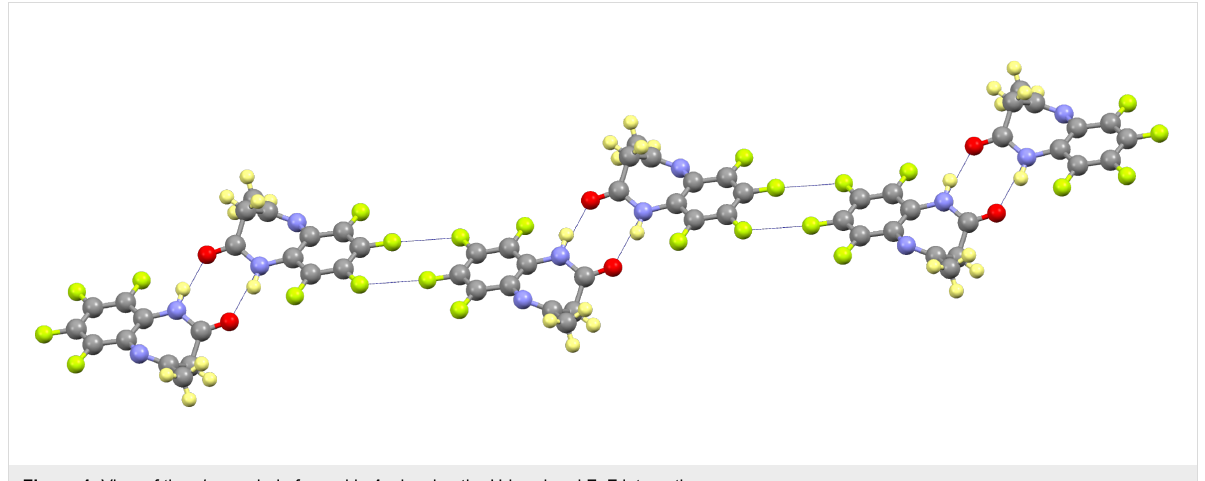
Figure 4: View of the zigzag chain formed in 1 , showing the H-bond and F–F interactions.